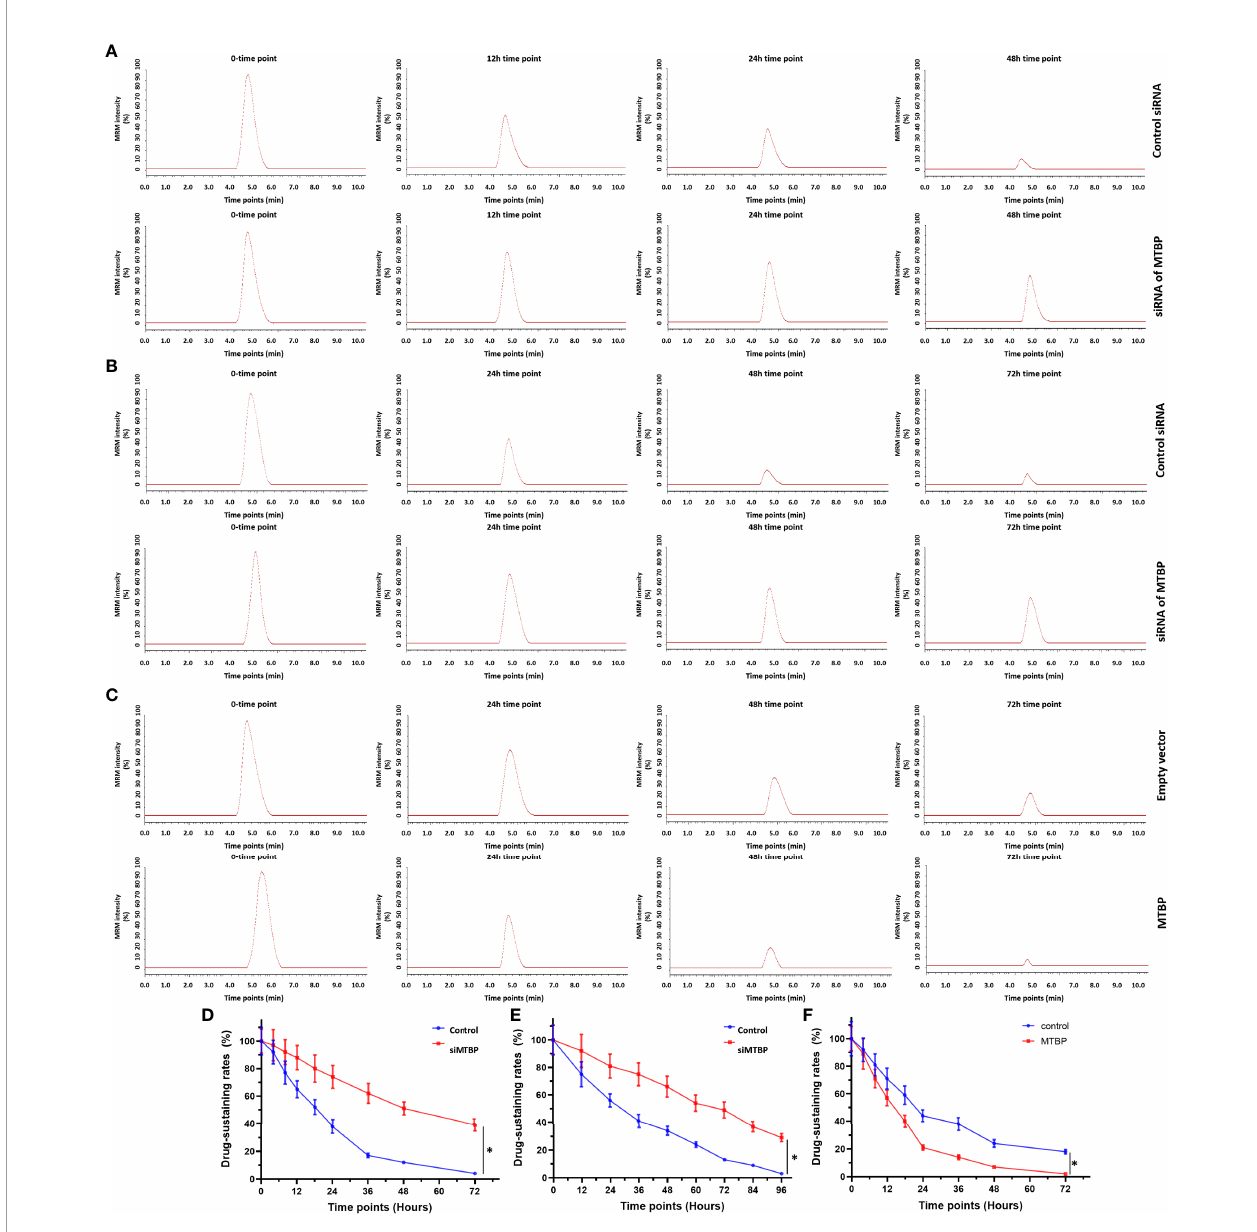
FIGURE 5 | MTBP accelerates the clearance or metabolism of sorafenib in HCC cells. (A, B) The MHCC97-H (A, B) cells were transfected with a control siRNA or the siRNA of MTBP, whereas the MHCC97-L (C) cells were transfected with an empty vector or MTBP. The cells were cultured (A, C) and injected into nude mice to form subcutaneous tumor tissues. The sustaining of sorafenib in cultured HCC cells (A, C) or the subcutaneous tumors (B) was examined by the LC-MS/MS methods. The results were shown as the represented images of LC-MS/MS at represented time points or the drug sustaining curves (D – F) . *P <